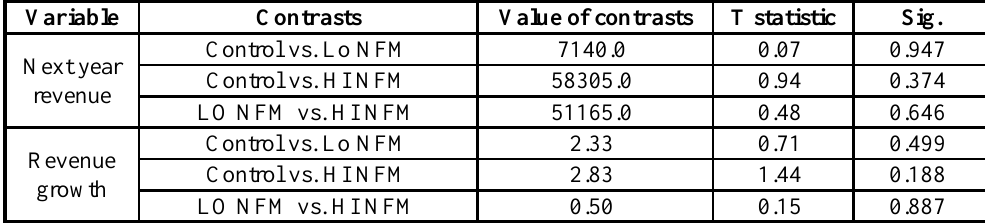
Table 6. Contrasts test (non-financial information alone and high knowledge)